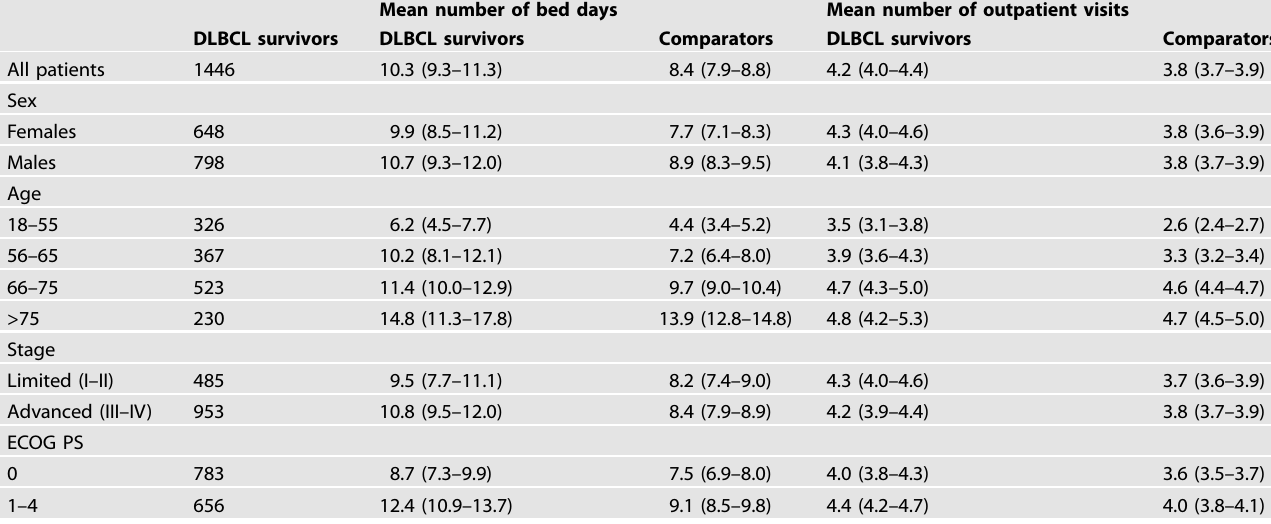
Table 2. The mean number of inpatient bed days and outpatient visits within 5 years of the index date (date of response evaluation + 90 days) for DLBCL survivors and matched comparators without